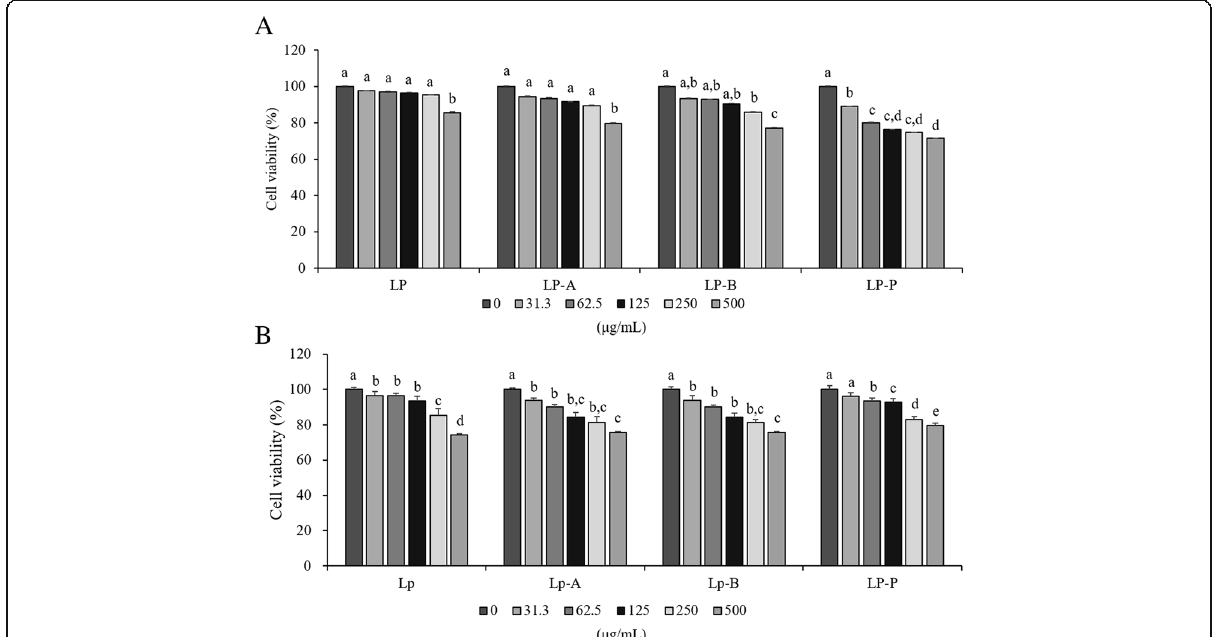
Fig. 1 Determination of the viability of a MG-63 cell and b hDPC (24 h). The values are the means ± SD of three independent experiments, and the cell proliferation effect on the hydrolysates was represented as a percentage. The letters a, b, c, d, and e above the bars stand for significantly different ( p < 0.05) groups by one-way ANOVA, followed by Duncan ’ s multiple test. Cell viability was determined by CCK assay. *Values are the means± SD of three independent experiments ( n = 3)